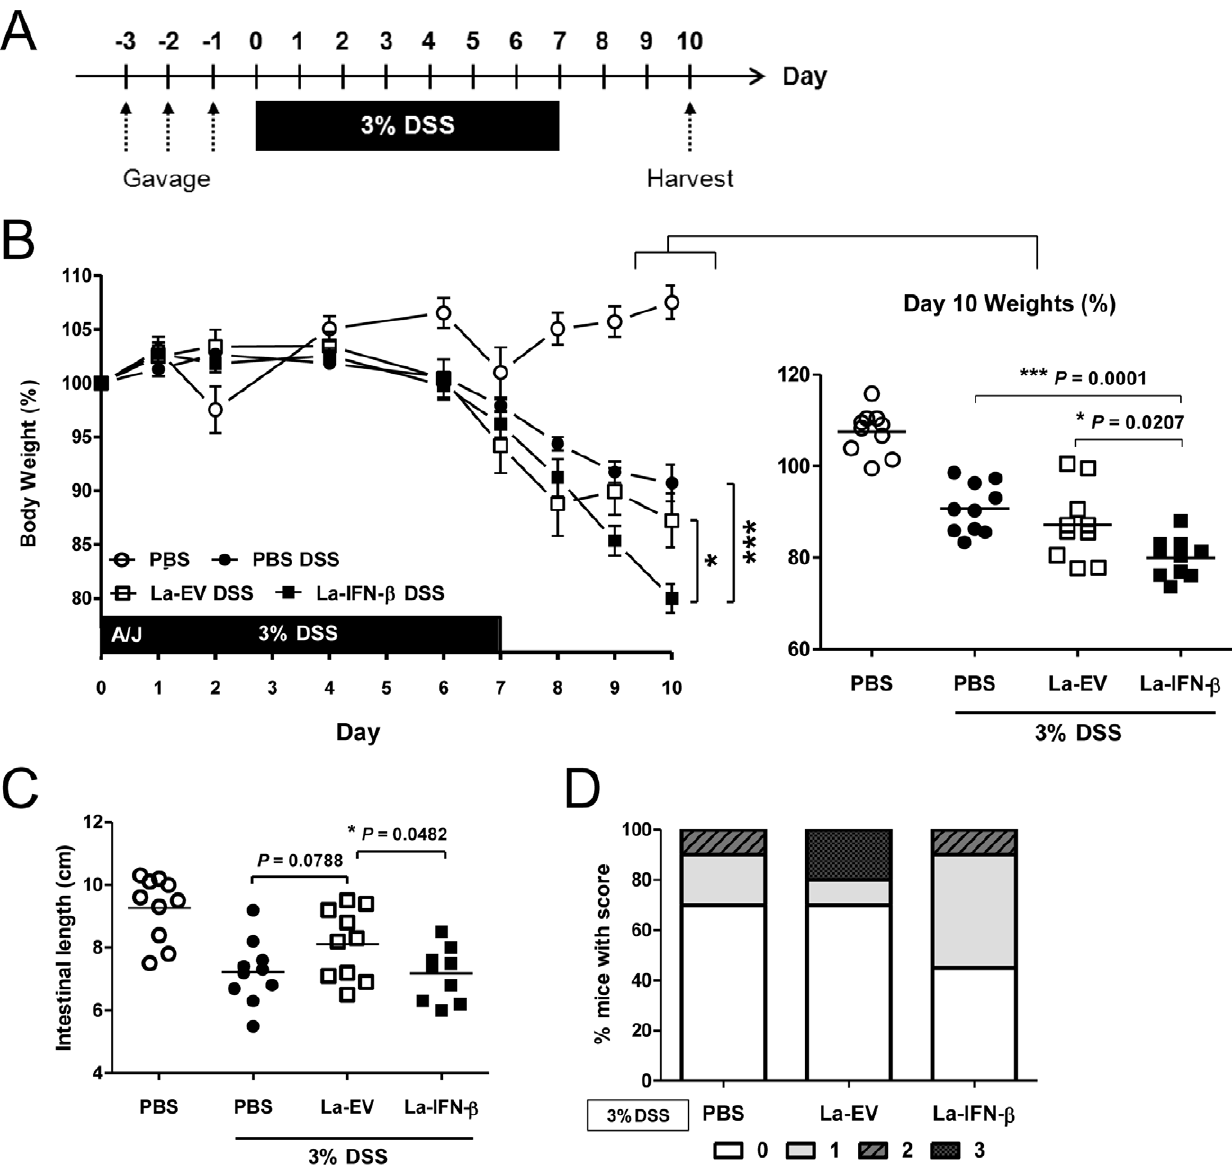
Figure 3. Pretreatment of mice with La-IFN- b exacerbates DSS-induced colitis. ( A ) On days -3, -2 and -1 mice were gastric gavaged with 10 9 CFU of the bacterial treatments and days 0-7 3% DSS was administered in the drinking water. ( B ) Percent body weight loss of mice pretreated with La-IFN- b , La-EV or PBS for three days. The 100% body weights were taken as the weights of mice just prior to DSS administration. Day 10 percent body weights are plotted to show individual mice (n=10). ( C ) Intestinal lengths (cm) of mice on day 10 following DSS administration. Colons were harvested and measured from the proximal end just below the cecum and to the anus (n=10). ( D ) Following the harvest of the colons, the tissue was macroscopically examined for severity and distribution of intestinal hemorrhaging and scored on a scale from 0–3 (0=no visible hemorrhaging, 1=diffuse hemorrhaging, 2=widespread hemorrhaging, 3=severe hemorrhaging throughout colon). Results shown are representative of three independent experiments.